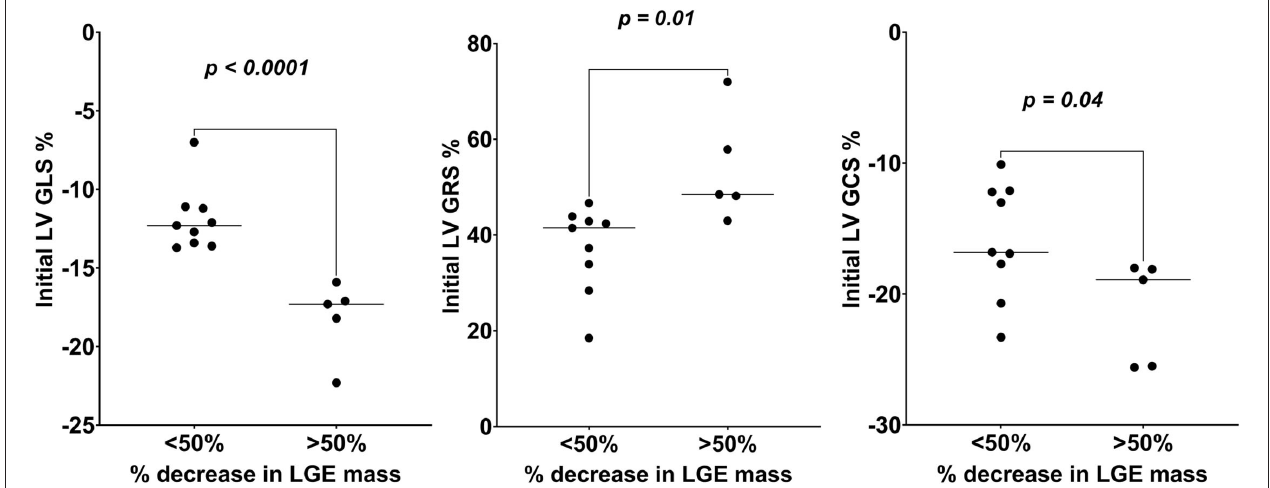
FIGURE 4 | Comparison of initial LV global strains (GLS, GRS, and GCS) values of those who had > 50 vs. < 50% decrease in LGE mass over the follow-up study period. LV GCS, left ventricular global circumferential strain; LV GLS, left ventricular global longitudinal strain; LV GRS, left ventricular global radial strain; LGE, late gadolinium